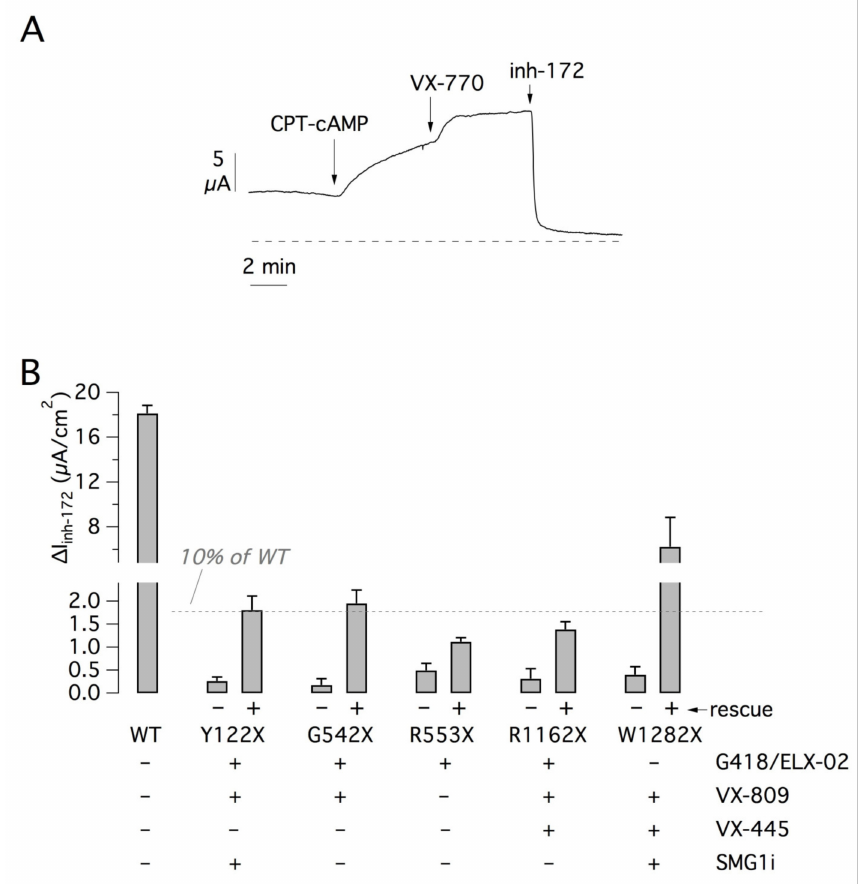
Figure 10. Extent of mutant CFTR rescue by pharmacological treatment. ( A ) Representative short- circuit current recording from 16HBE14o- cells expressing wild-type CFTR. ( B ) Bar graph showing the comparison of CFTR function in 16HBE14o- cells expressing wild-type or mutant CFTR. For cells carrying mutant CFTR, the bars report CFTR function (mean plus SD) under control conditions and after rescue with the most effective treatment for each mutation as